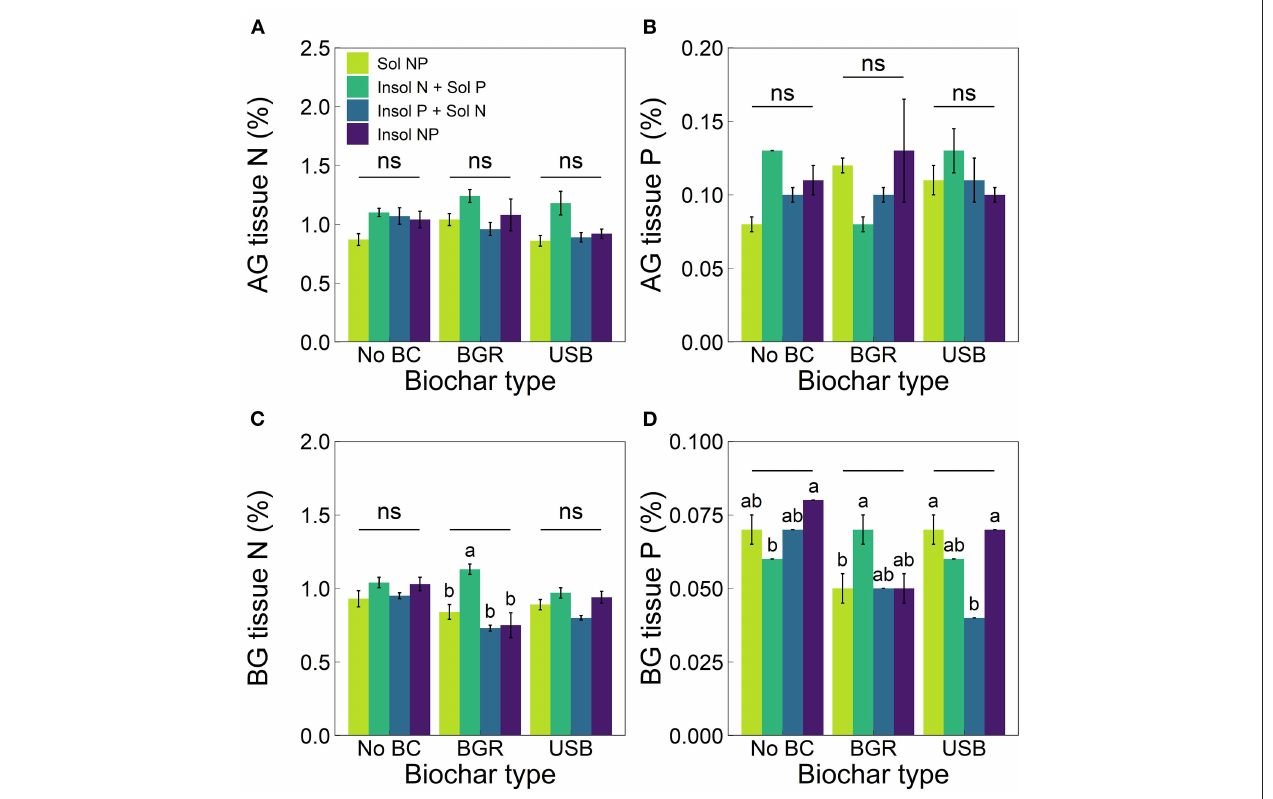
FIGURE 3 | Means ( ± SE) of (A) aboveground (AG) total plant tissue N, (B) AG total plant tissue P, (C) belowground (BG) total plant tissue N and (D) BG total plant tissue P for biochar (x-axis) and nutrient treatments (varied colors). Lowercase letters indicate significant differences (Tukey post-hoc tests, p < 0.05) among nutrient treatments within biochar type and “ns” indicates no significant differences. Significant differences among biochar types within nutrient treatments are displayed in Supplementary Table 2 . The x-axis label “No BC” stands for No Biochar treatments.